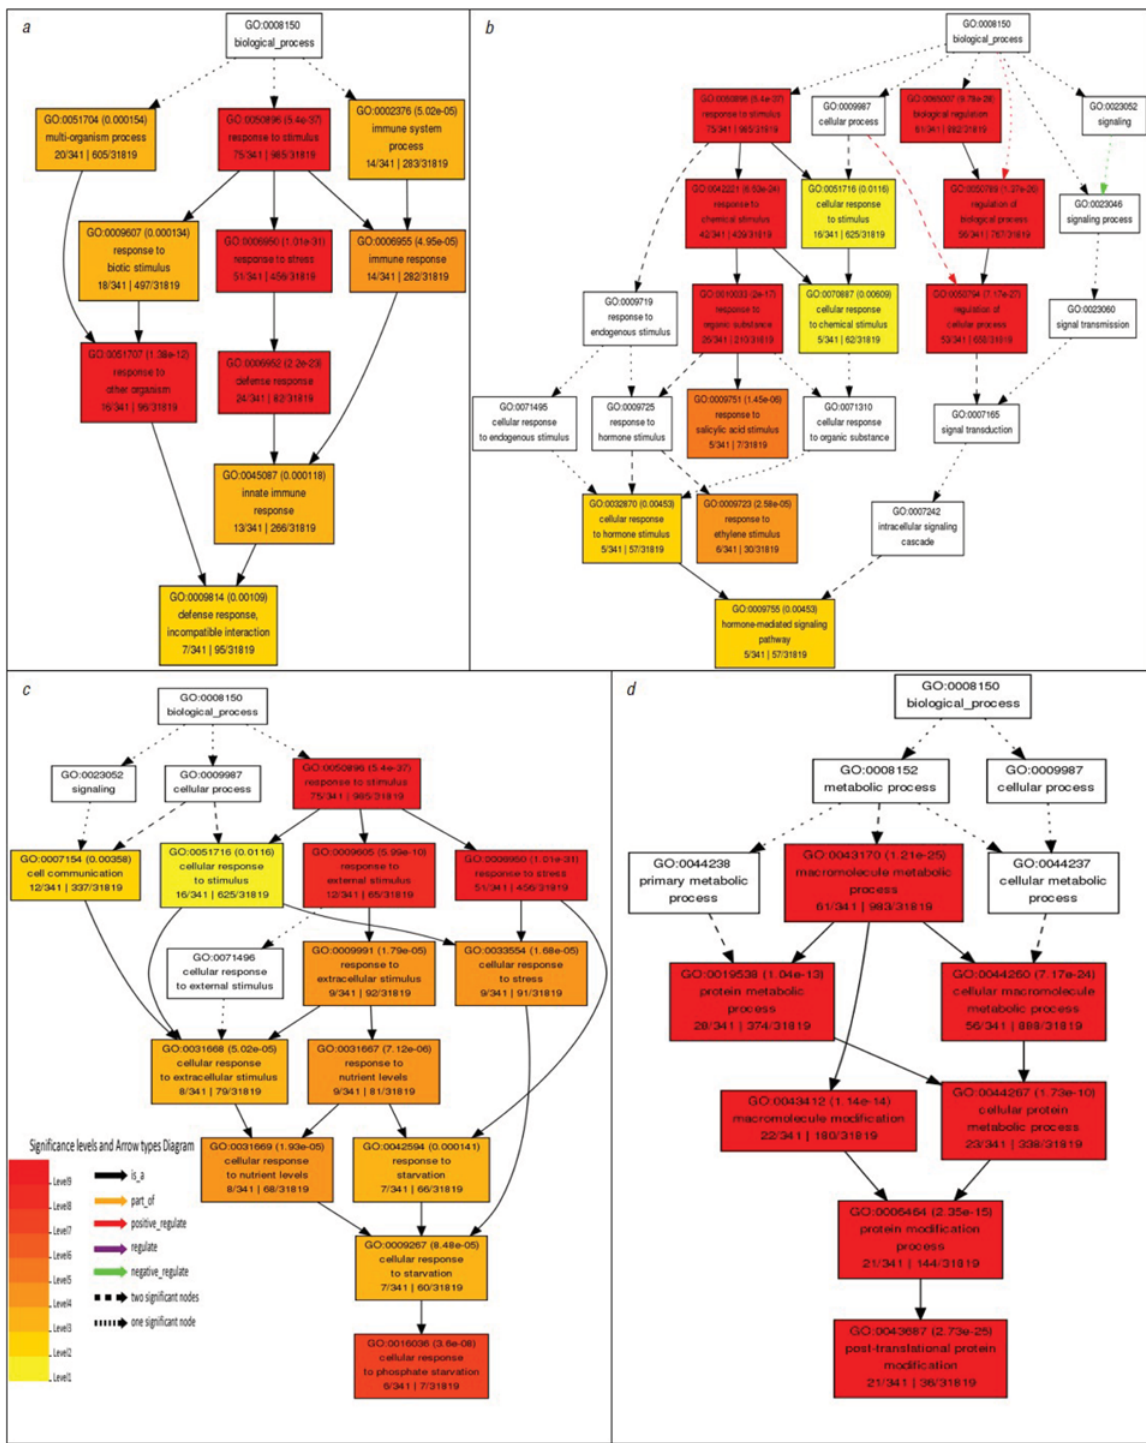
Fig 5. Singular enrichment analysis (SEA) of the DEGs using AgriGO into important biological processes. (a) Stress response (b) Hormone response (c) Response to Phosphate starvation (d) Protein modification.